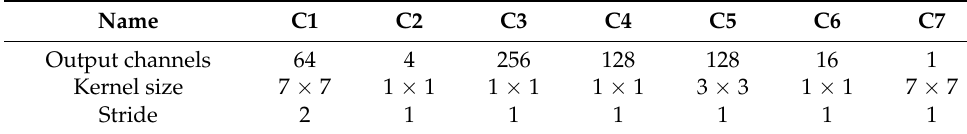
Figure 2. Model Architecture: The yellow rectangle represents the 2-d convolutional layer; the red rectangle represents the attentional residual module; the blue rectangle in the hourglass-style represents normal residual module; the green rectangle represents the integral regression layer, which converts heatmaps into keypoints; each convolutional layer is followed by a ReLU operation. Table 1. Parameters of convolutional layers in HeadNet.